Question: How would you classify this visualization?
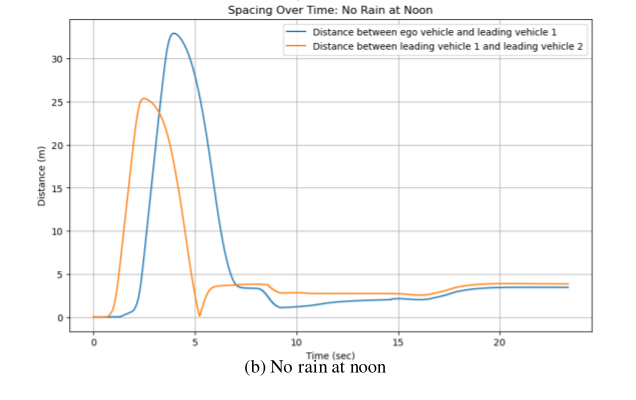
Answer: line